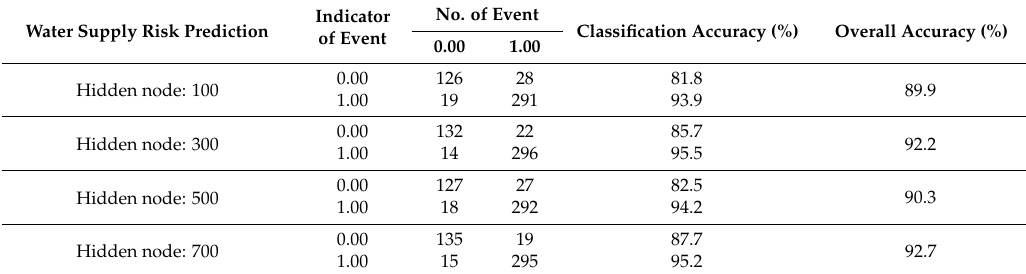
Table 3. Analysis of water risk prediction model using Multi-Layer